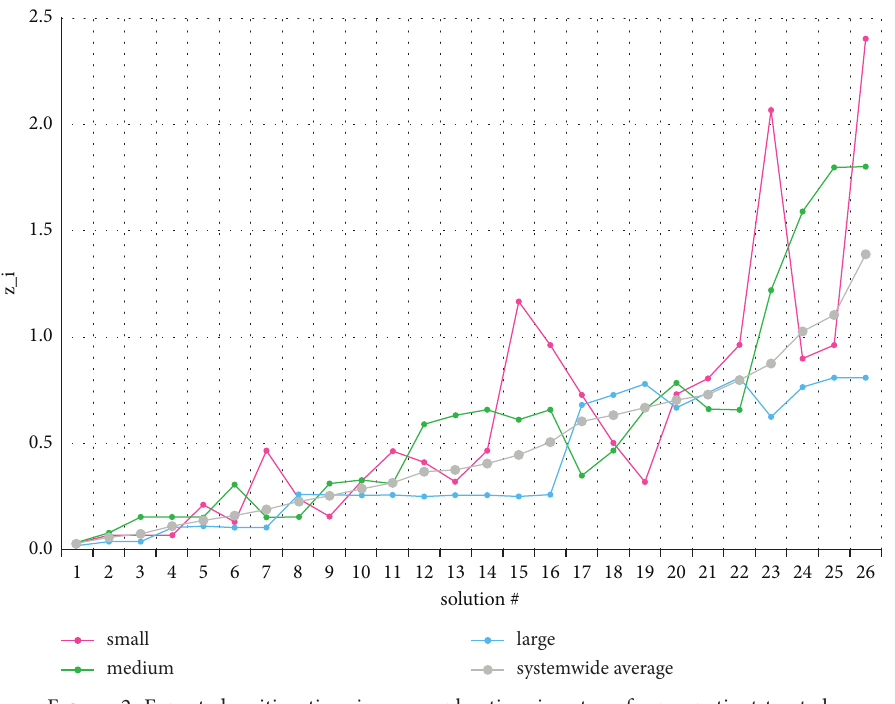
Figure 2: Expected waiting time in queue plus time in a transfer per patient